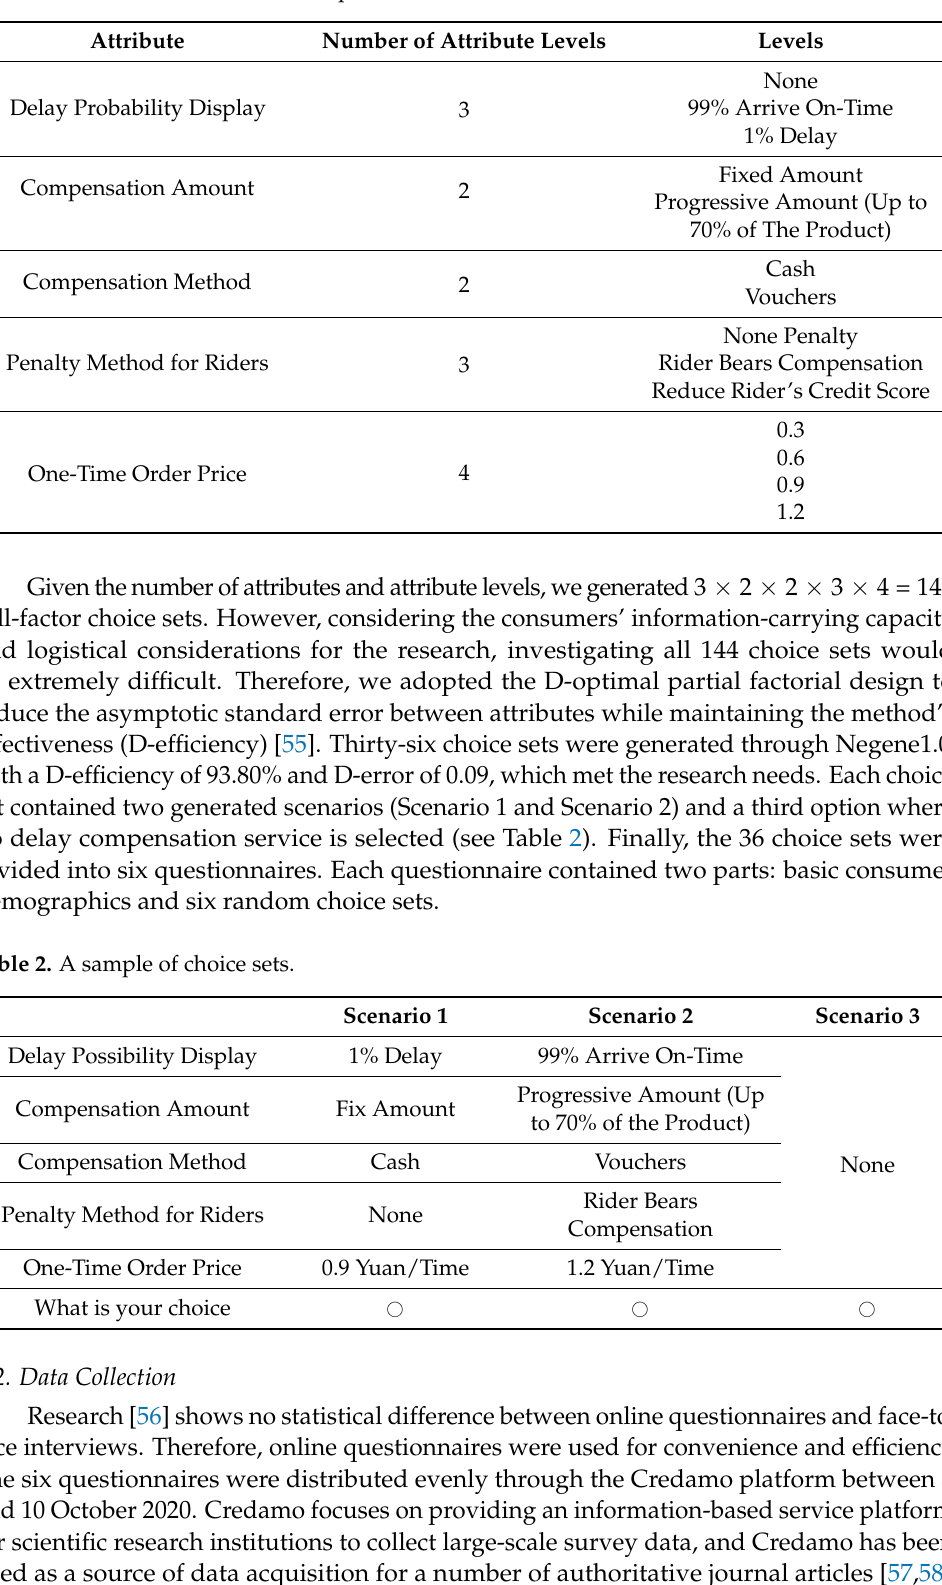
Table 1. Attributes and levels of compensation services.